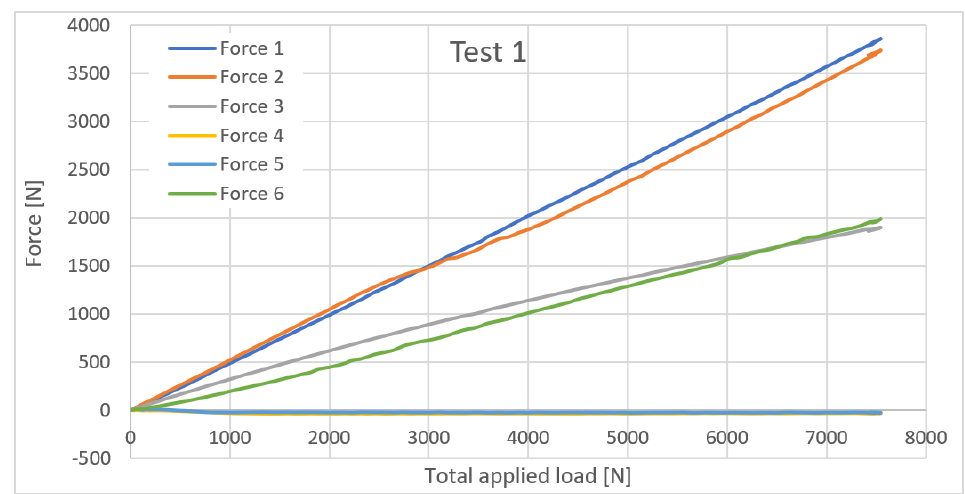
Figure 11. Total force redistribution into individual load cells during test one.